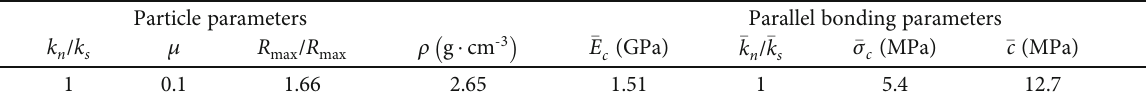
Table 3: Micromechanical parameters of simulated samples [30].